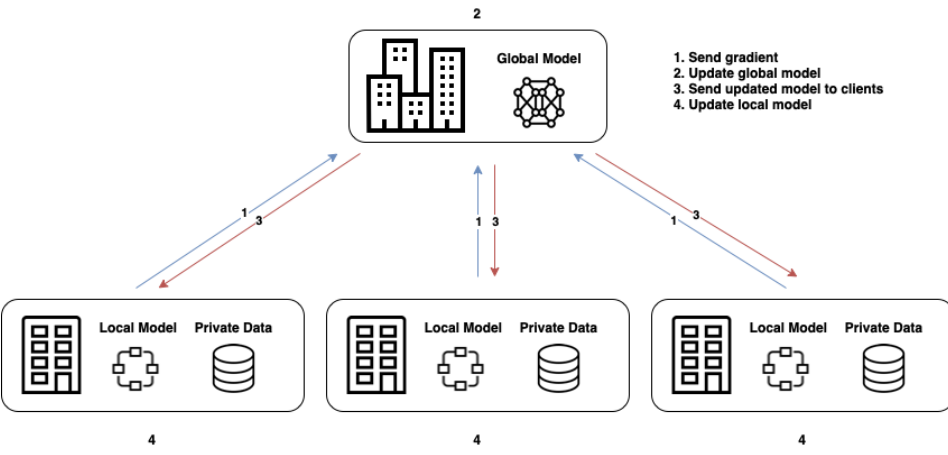
Figure 2. Architecture design of